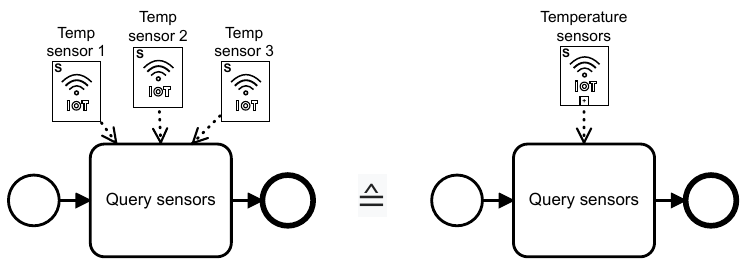
Figure 5. Usage of Sensor Artifact and Sensor Group